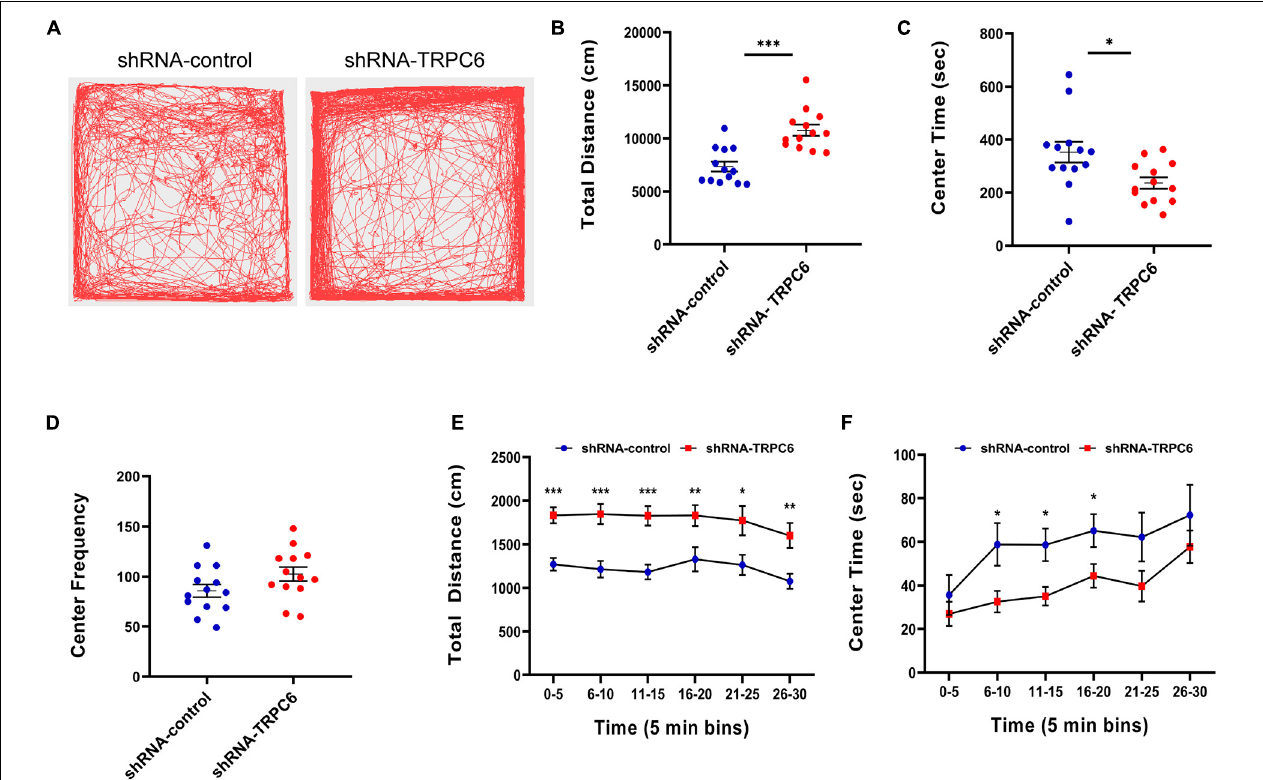
FIGURE 5 | Down-regulation of TRPC6 affected exploratory abilities and anxiety-like behavior in mice. (A) Representative traces displaying the total distance traveled over the 30-min period by the experimental mice between the two groups in the open-field test. (B) Scatter plot showed a significant difference between the two groups in terms of total distance. (C) Mice in the shRNA-TRPC6 treated group spent less time in the centre than the control group. (D) Frequency of access to the central area. (E) The total distance over 30 min in 5-min bins. (F) The center time over 30 min in 5-min bins. Sample sizes for each group: n = 13. Data were presented as mean ± SEM. * p < 0.05, ** p < 0.01, *** p <